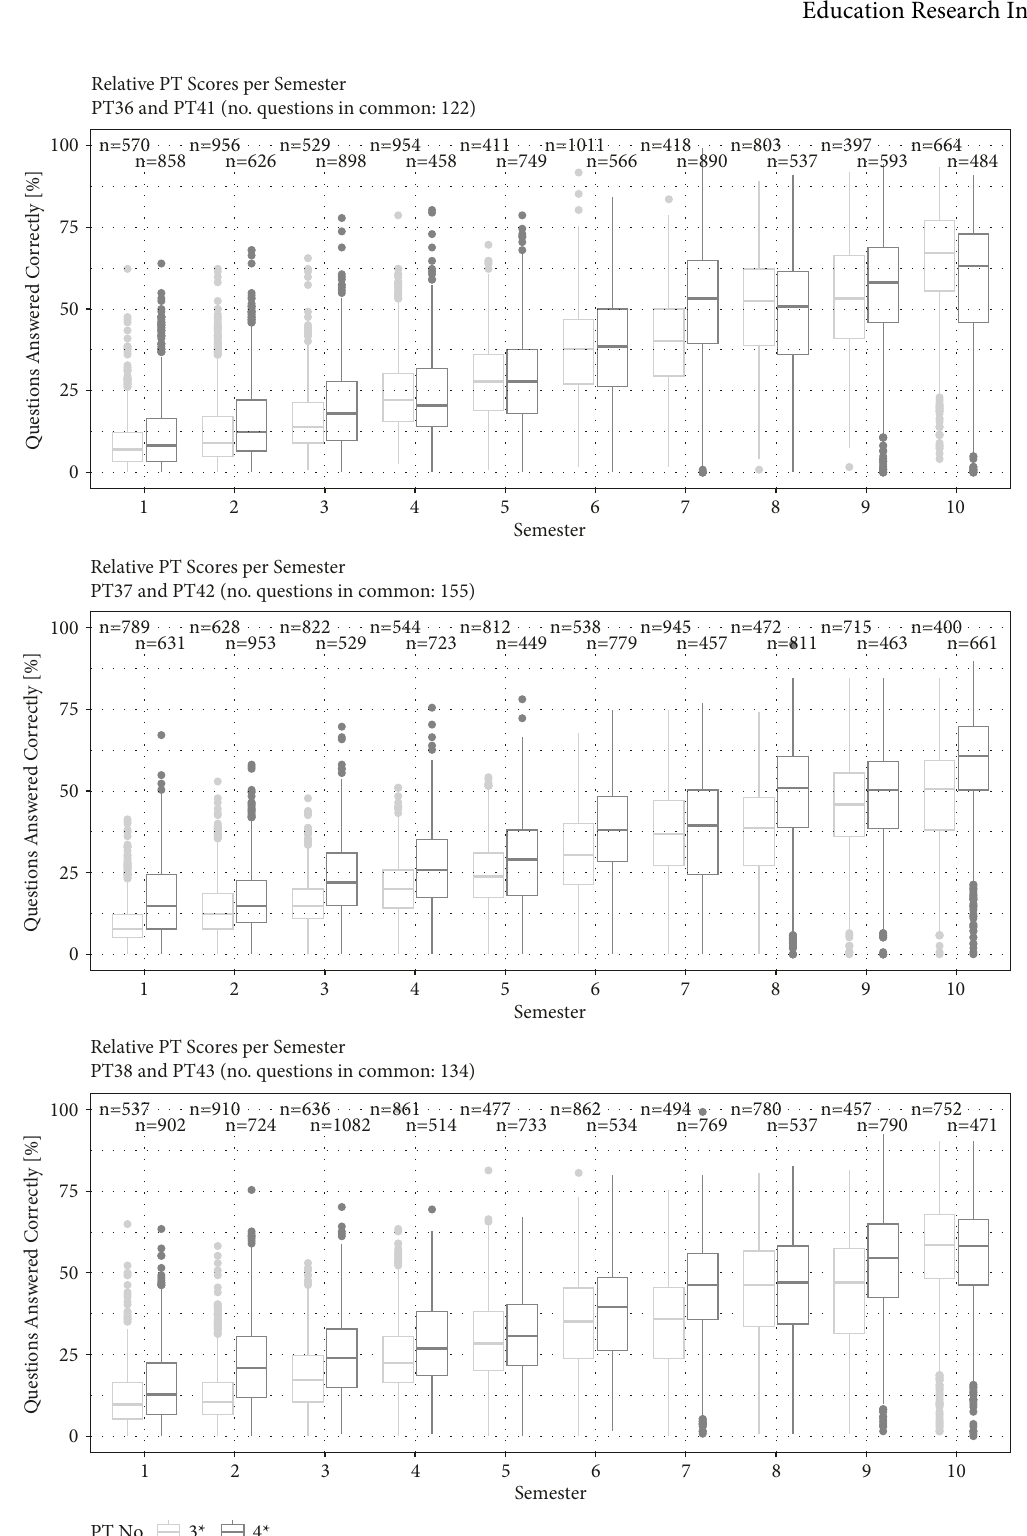
Figure 3: Relative PT scores per semester. Each PT shares a considerable number of questions with the PT that took place five semesters prior; therefore, PTs conducted five semesters apart from each other can be naturally paired together (PTpair). Boxplots show an overview of the percentage share of correctly answered questions in each PTpair by students enrolled at nine faculties in Germany and Austria. Data are disaggregated by semester; plots in light gray refer to data from earlier PTs (36 � summer semester 2017, 37 � winter semester 2017/18, 38 � summer semester 2018), while plots in dark gray represent later PTs (41 � winter semester 2019/20, 42 � summer semester 2020, and 43 � winter semester 2020/21, respectively). For each semester and PT, the number of participants is indicated above the corresponding boxplot. PT, Progress